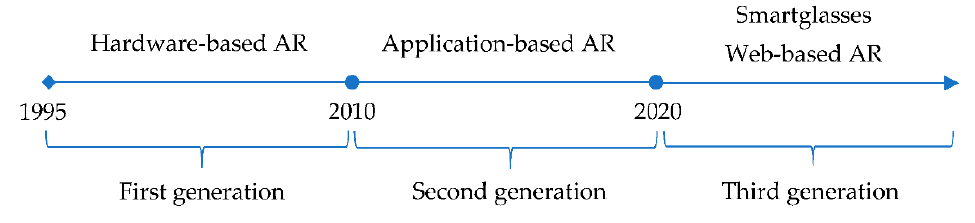
Figure 2. Three generations of AR in education.